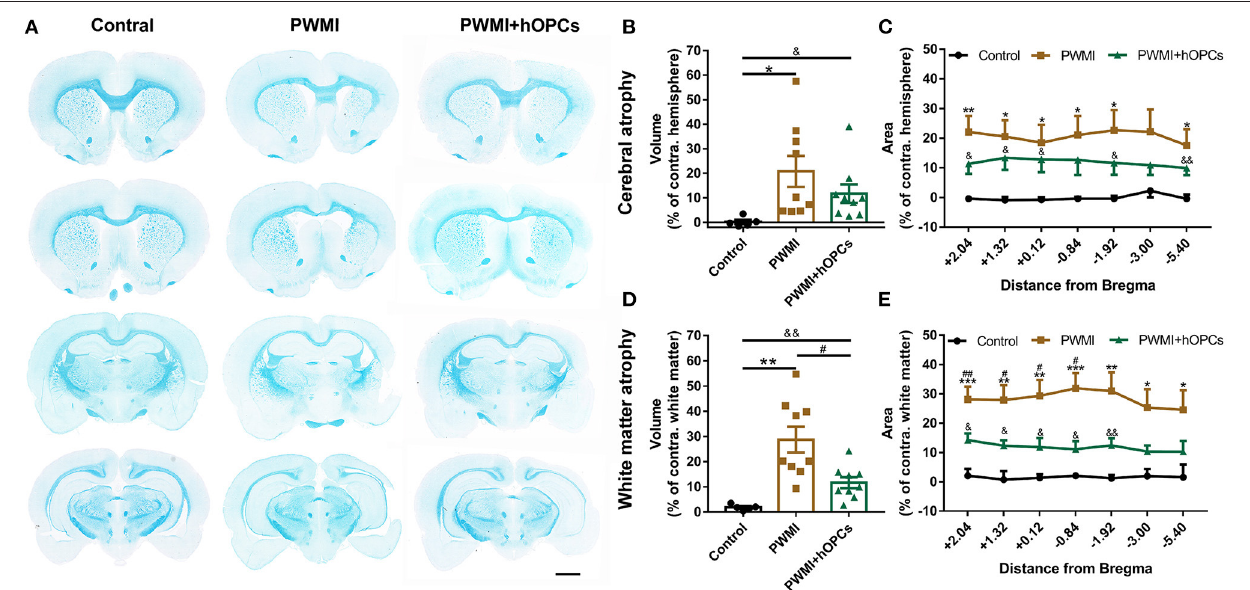
FIGURE 4 | Measurement of cerebral atrophy and white matter atrophy. (A) Representative coronal sections stained with LFB demonstrate prominent white matter atrophy in the PWMI group and restoration following transplant. Scale bar = 2mm. (B,C) Cerebral atrophy area in specific coronal sections and cerebral atrophy volume were analyzed between groups ( n = 5 for controls, n = 9 for PWMI and PWMI + hOPCs; seven sections per rat; Brown-Forsythe test with Dunnett’s T3 for multiple comparisons). (D,E) White matter atrophy area in specific coronal sections and white matter atrophy volume were compared between groups ( n = 5 for controls, n = 9 for PWMI and PWMI + hOPCs; seven sections per rat; Brown-Forsythe test with Dunnett’s T3 for multiple comparisons). Data are presented as mean ± SEM; PWMI vs. control: * P < 0.05, ** P < 0.01, *** P < 0.001; PWMI + hOPCs vs. PWMI: # P < 0.05, ## P < 0.01; PWMI + hOPCs vs. control: & P < 0.05, && P <